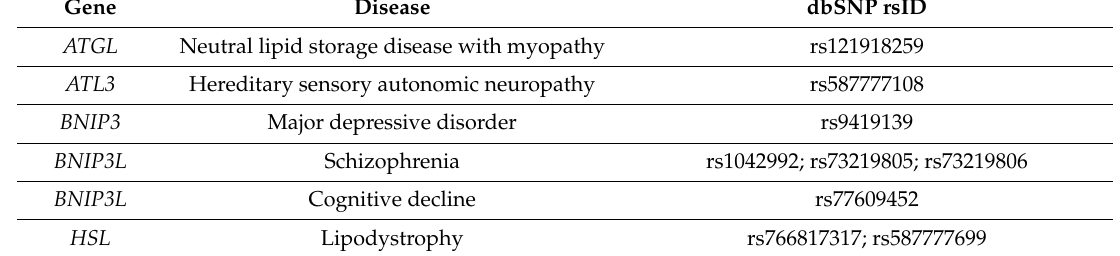
Table 5. Clinically relevant SNPs in selective autophagy